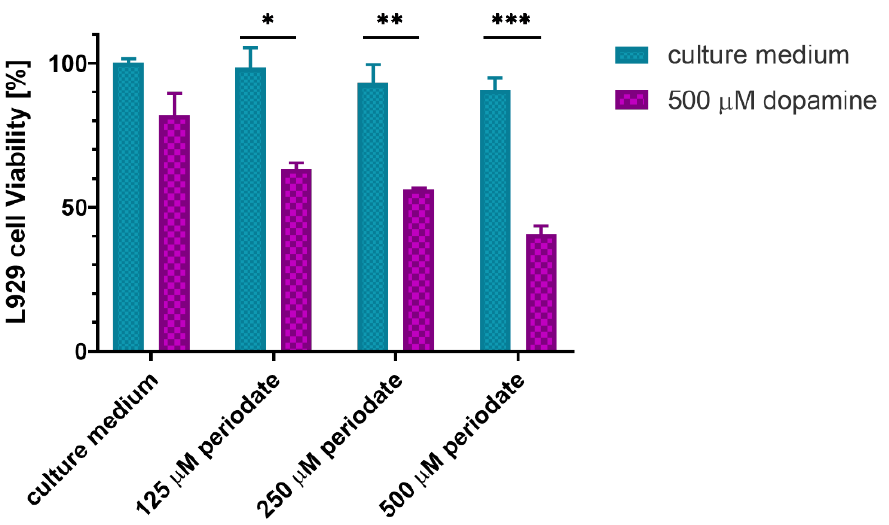
Figure 8. L929 cell viability after 24 h incubation with combinations of dopamine and sodium periodate. n = 3, error bars = SD. * p = 0.03, ** p = 0.003, *** p < 0.0001.